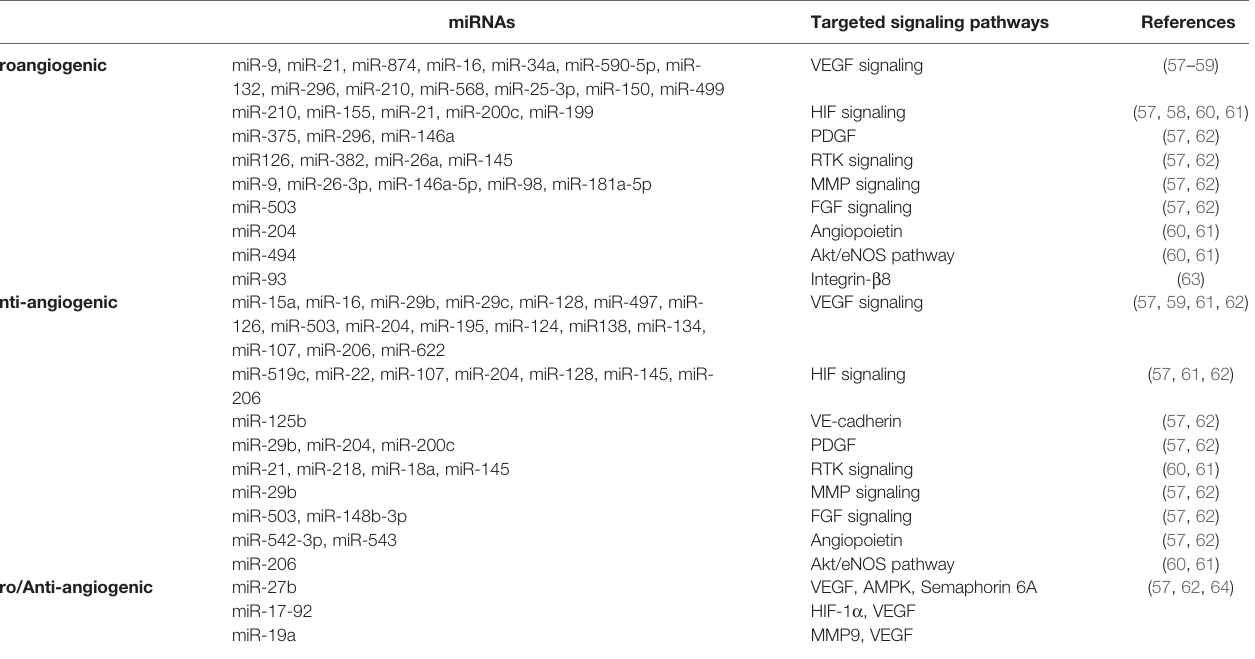
TABLE 3 | List of miRNAs regulating angiogenesis in tumor microenvironment.